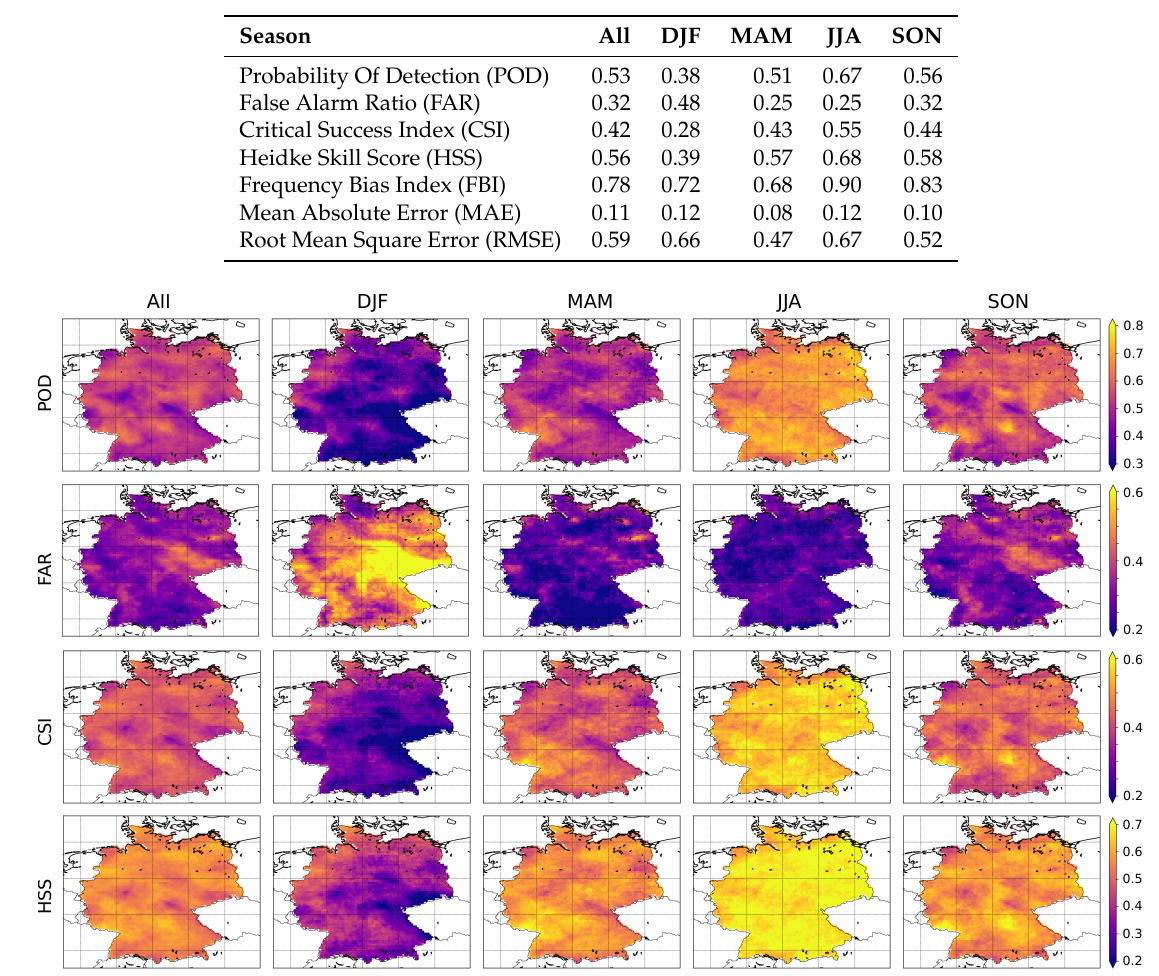
Table 2. Categorical indices per season.